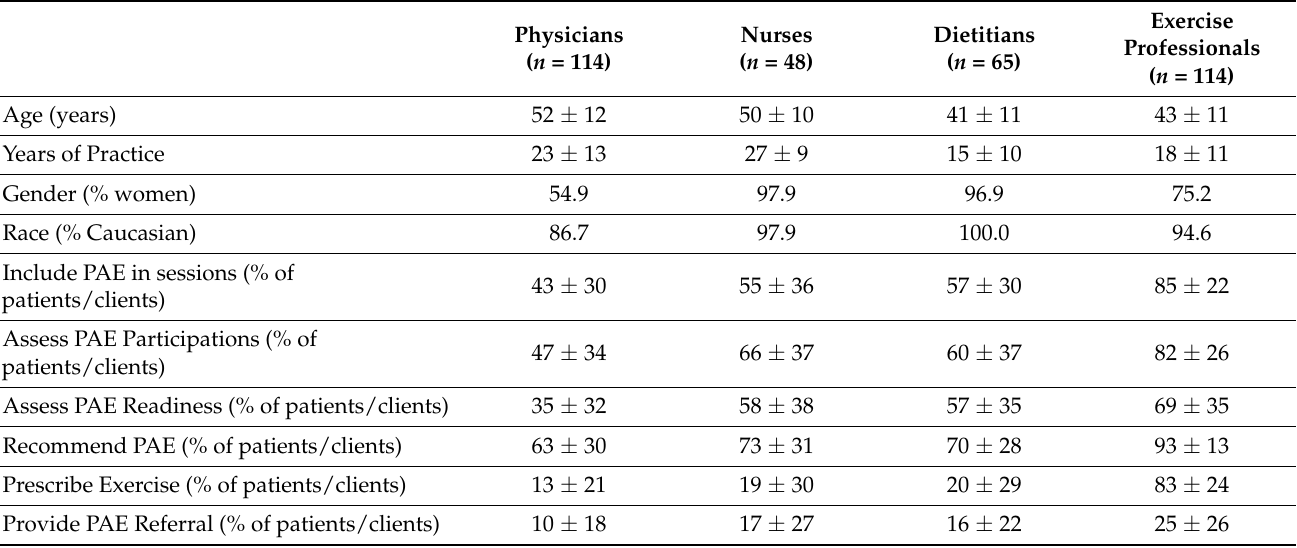
Table 1. Participant characteristics and physical activity counselling or exercise prescription practices across physicians, nurses, dietitians, and exercise professionals.